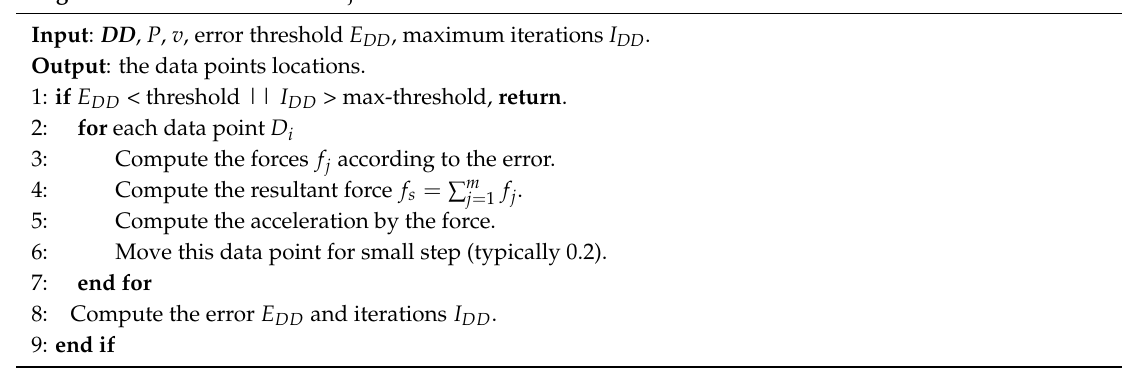
Algorithm 3. Force Directed Adjustment of the Data